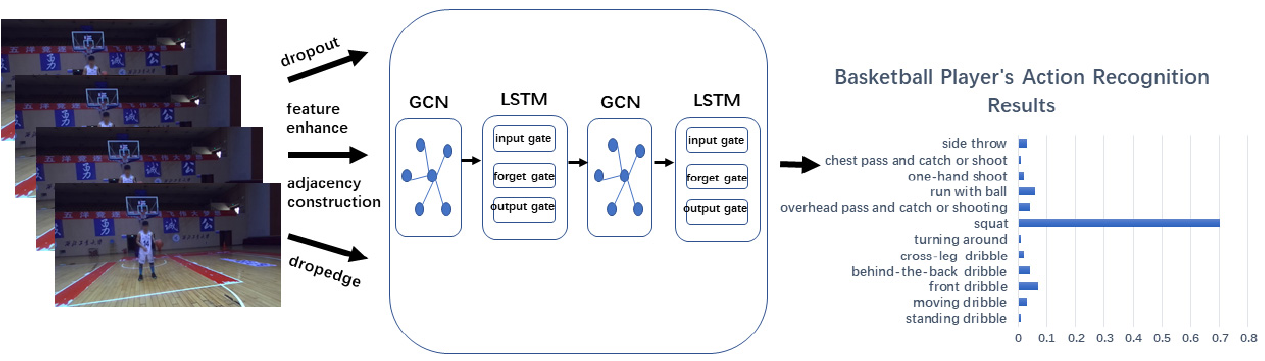
Figure 7. The pipeline of the proposed LSTM-DGCN.